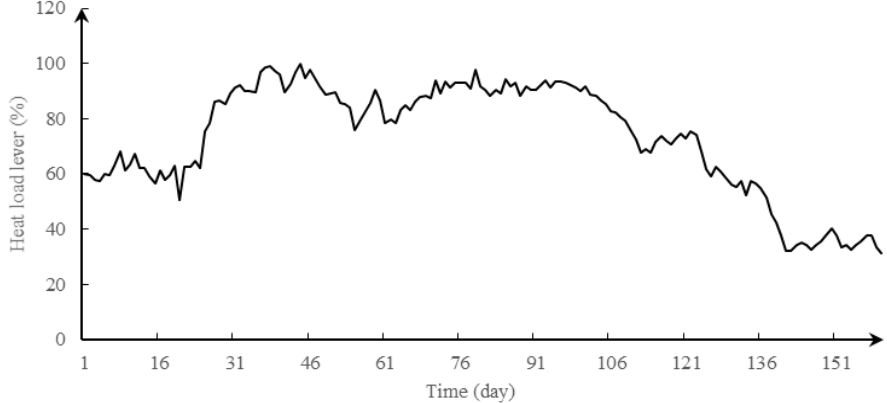
Figure 8. The daily heat load level during heating